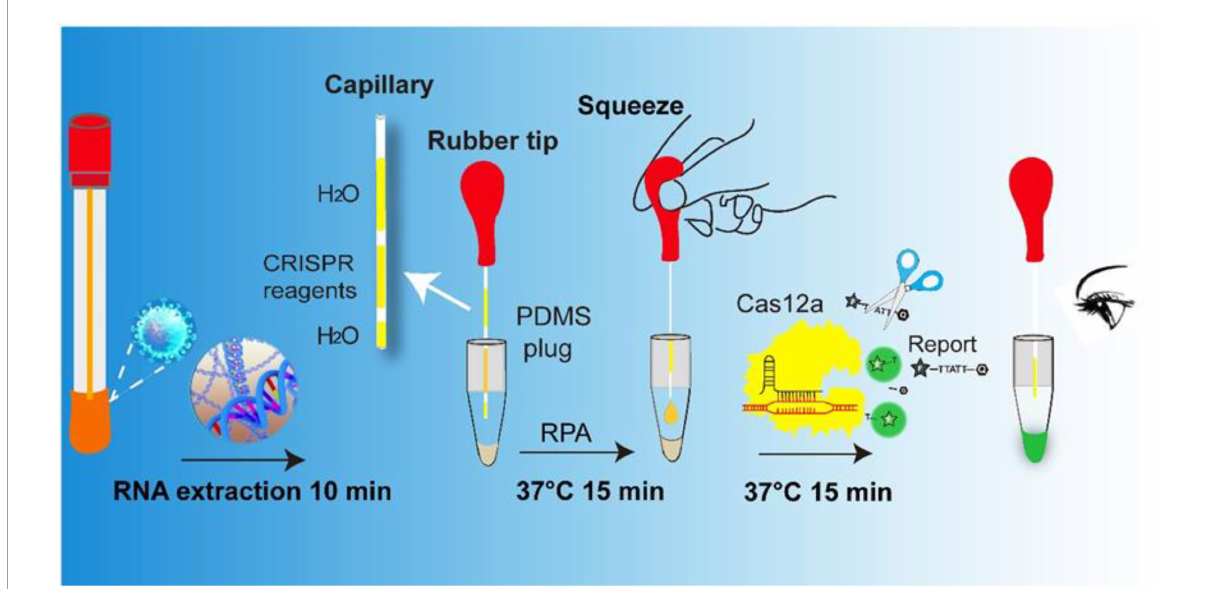
FIGURE1 Scheme of the integrated tube assay platform for SARS-CoV-2 detection with the naked eye. Nucleic acids were extracted from the nasopharyngeal swabs (10 min) and then subjected to RT-RPA analysis at 37 ◦ C for 15 min. The corresponding RT-RPA products were verified by CRISPR-Cas12 system. The rubber tip was gently pressed and CRISPR reagents droplet was introduced into the amplified products. The reaction was conducted at 37 ◦ C for another 15 min and the results was observed by naked eye under a blue light gel imager.